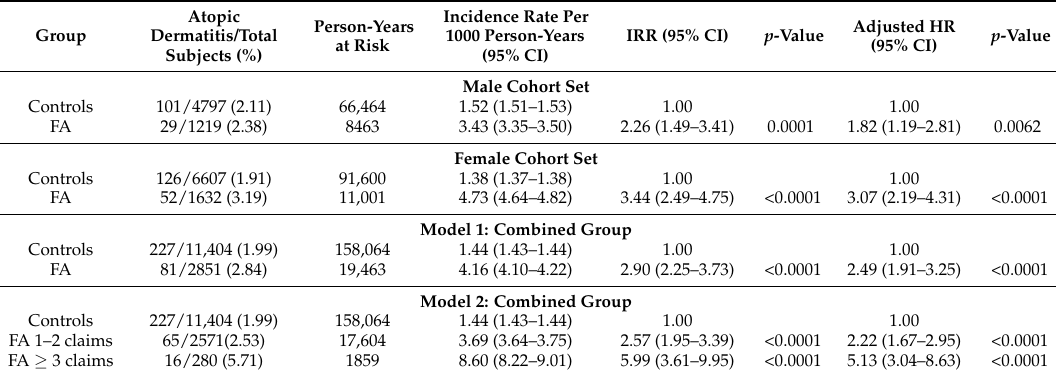
Table 2. Adult food allergy patients are at risk of developing atopic